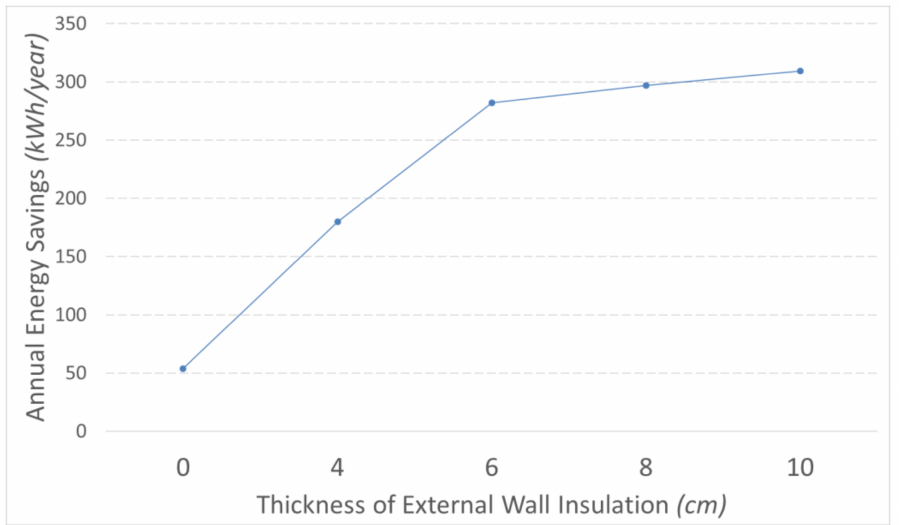
Figure 10. Ventilated façade including external wall